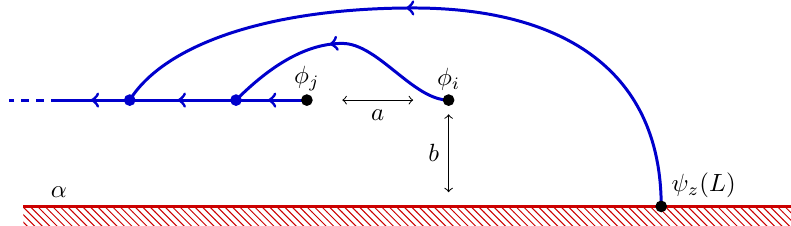
Figure 3 . Two bulk (cid:12)elds and one boundary (cid:12)eld together with their defect lines as used in computing the crossing constraint linking bulk-boundary couplings and bulk structure